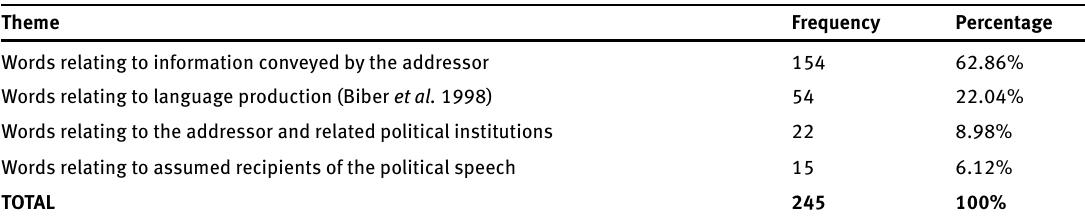
Table 2. Frequencies and percentages of keywords categorised in each